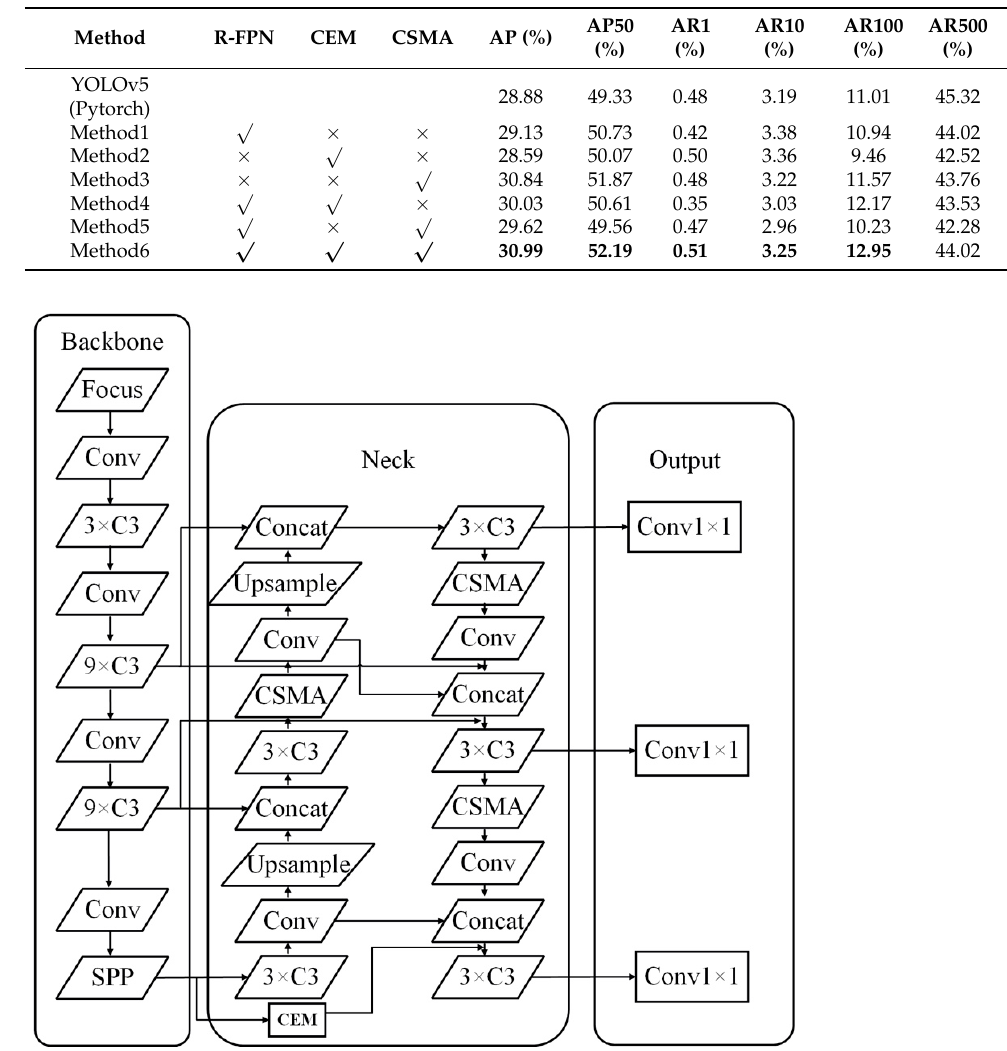
Figure 8. The Structure of the improved model. Table 2. Detection Precision of Different Models.